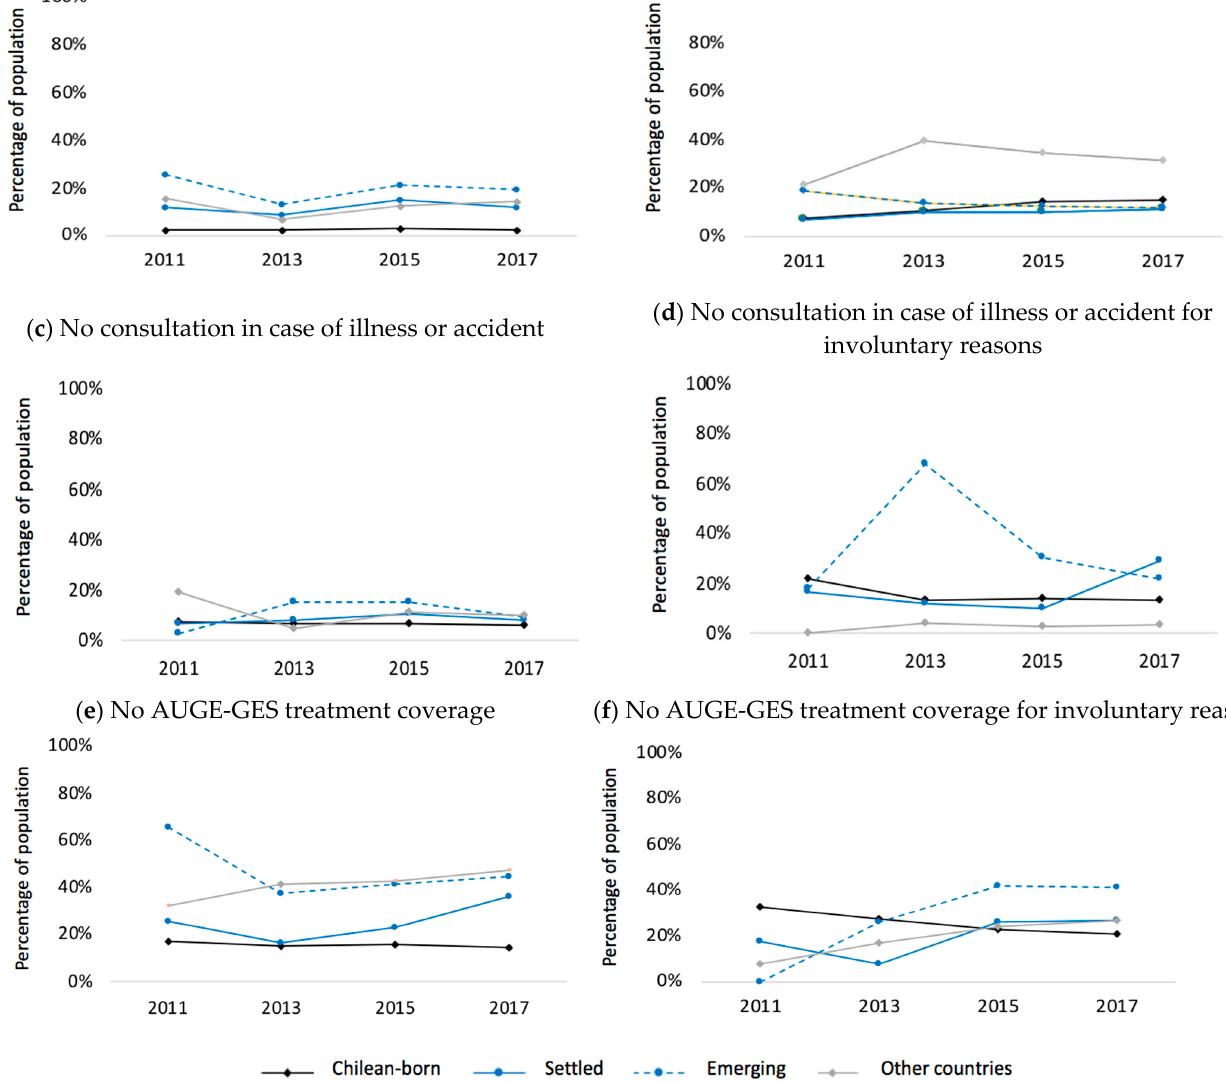
Figure 1. Indicators of access and use of health care services in Chilean-born population and immigrant population (settled, emerging, and other countries). Chile 2011–2017. Settled: Peru, Argentina, Bolivia, Ecuador. Emerging: Venezuela, Dominican Republic, Colombia, Haiti. Others: Migrants from other countries: remaining countries and does not know, does not respond to country of origin. Percentage of: ( a , b ) total population, ( c ) population with illness or accident during the three months prior to the survey, ( d ) population that did not consult in case of illness or accident, ( e ) population under AUGE-GES treatment (21 consulted diseases), ( f ) population without AUGE-GES coverage. Chi-2 test, p -value: Migration-uninsured: 2011 (0.0366), 2013 (0.0000), 2015 (0.0464), and 2017 (0.0014). Migration-insured: 2011 (0.0000), 2013 (0.0000), 2015 (0.0000), and 2017 (0.0000). Migration-No consultation: 2011 (0.0159), 2013 (0.4425), 2015 (0.7467), and 2017 (0.4700). Migration-No consultation for involuntary reason: 2011 (0.0927), 2013 (0.0000), 2015 (0.0910), and 2017 (0.0536). Migration-no coverage: 2011 (0.3118), 2013 (0.0398), 2015 (0.0322), and 2017 (0.3808). Migration-Non-coverage for involuntary reason: 2011 (0.1869), 2013 (0.0100), 2015 (0.4114), and 2017